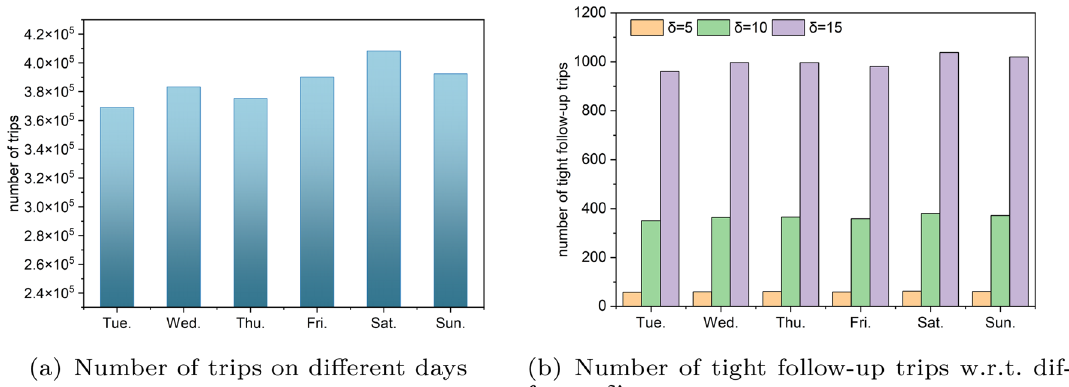
Fig. 13 Statistics of taxi